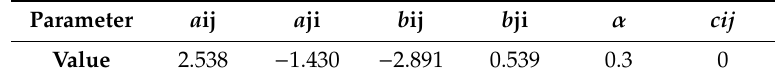
Table 2. Binary interaction parameters for NRTL equations for the urea–water system.